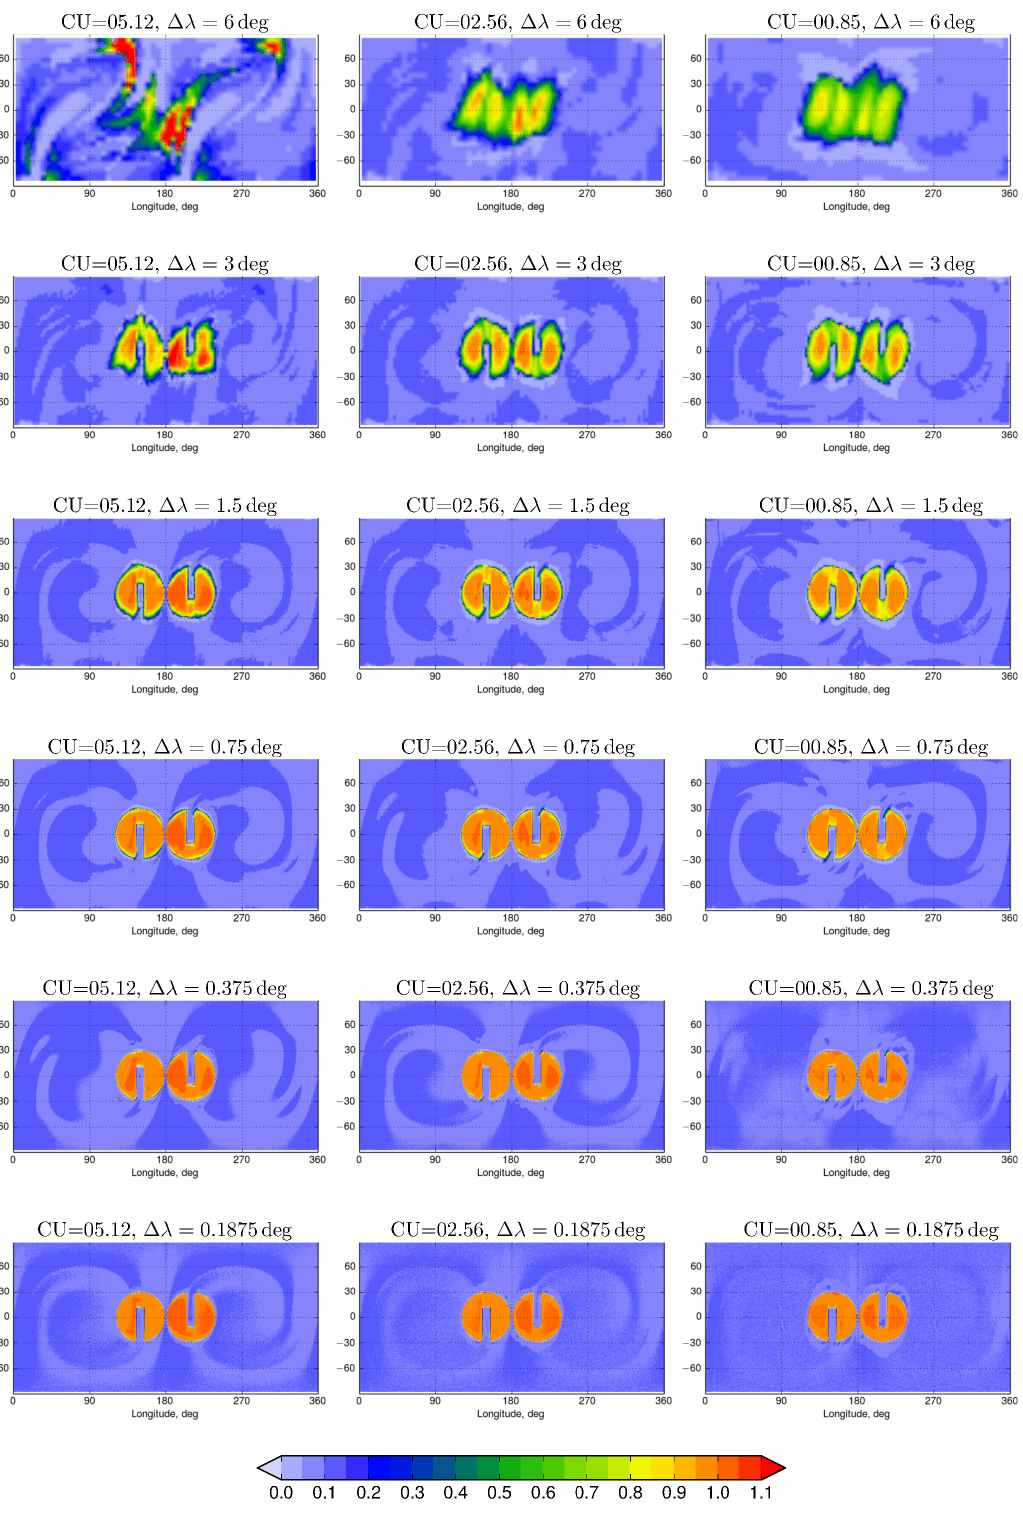
Figure 10. Final shapes ( t = T ) for the 2-D global tests with slotted cylinders for different spatial and temporal resolutions. Without